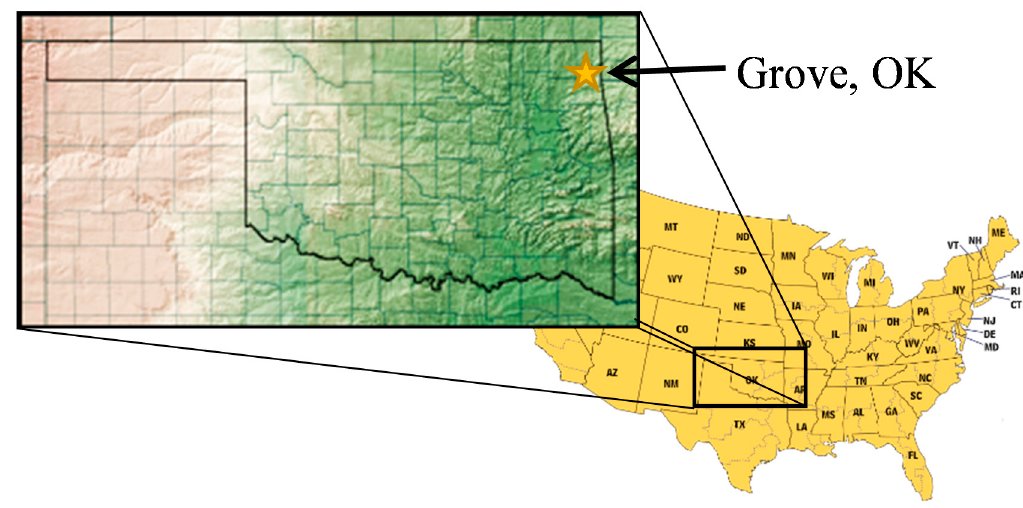
Figure 1. Locations of Grove BRC.